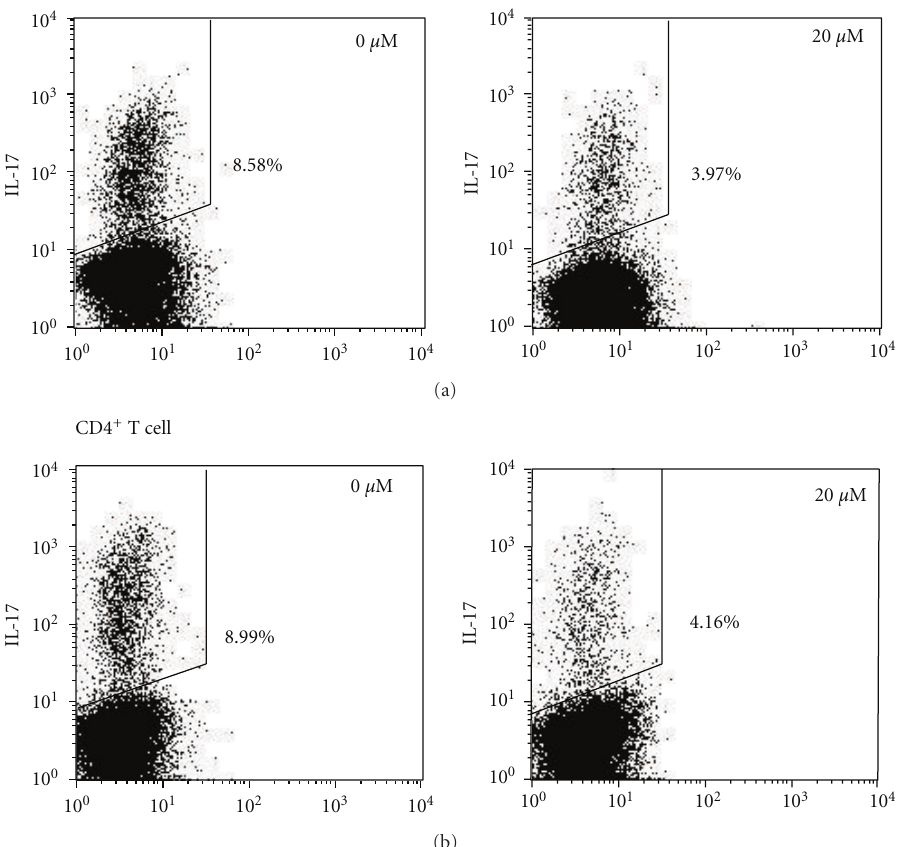
Figure 2: The e ff ect of fenofibrate on Th17 cell di ff erentiation did not involve changes of IFN- γ and IL-4 secretion. Total T cells (a) and CD4 + T cells (b) were isolated from mouse spleens and induced di ff erentiation to Th17 cells with 10ng/mL TGF- β , 40ng/mL IL-6, 5 μ g/mL IFN- γ neutralizing antibody, 5 μ g/mL IL-4 neutralizing antibody, and fenofibrate final concentrations indicated. 4 days later, the percentage of IL-17 + T cells was analyzed with flow cytometry. Numbers adjacent to the outlined areas indicate the percentage of IL-17 + cells. Data shown here represent one of three independent